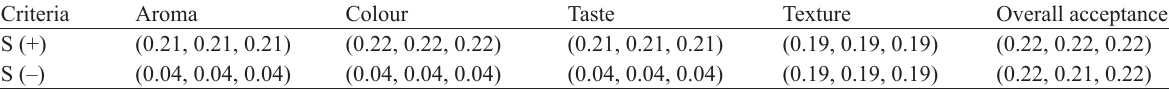
Table 12 Positive ideal solution and negative ideal solution values